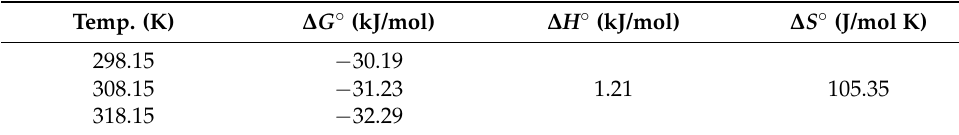
Table 4. Thermodynamic parameters of the adsorption of RY2 by PEI/PVC-CF. Temp.